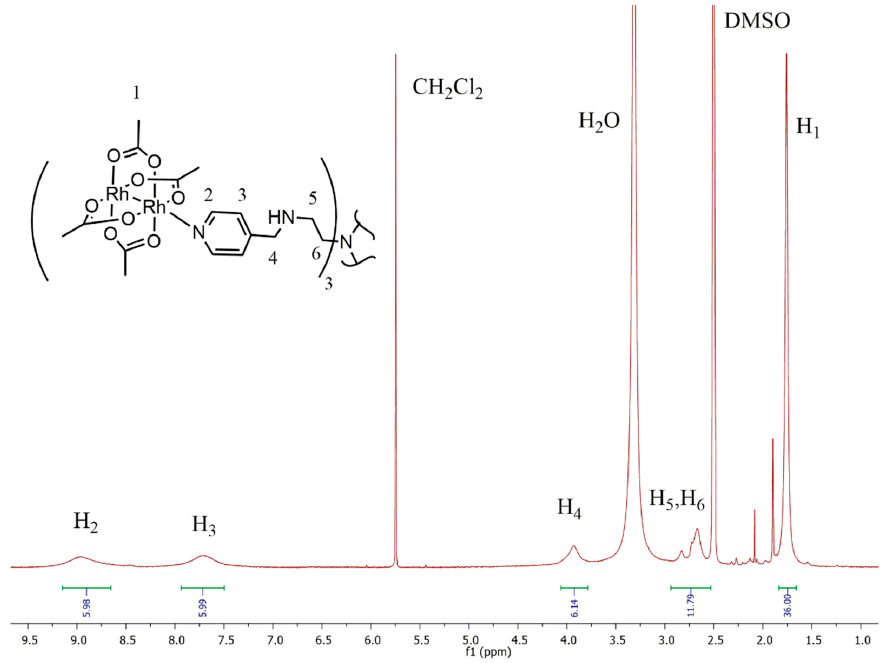
Figure 3. 1 H-NMR spectra obtained for complex 8 in DMSO- d 6 .